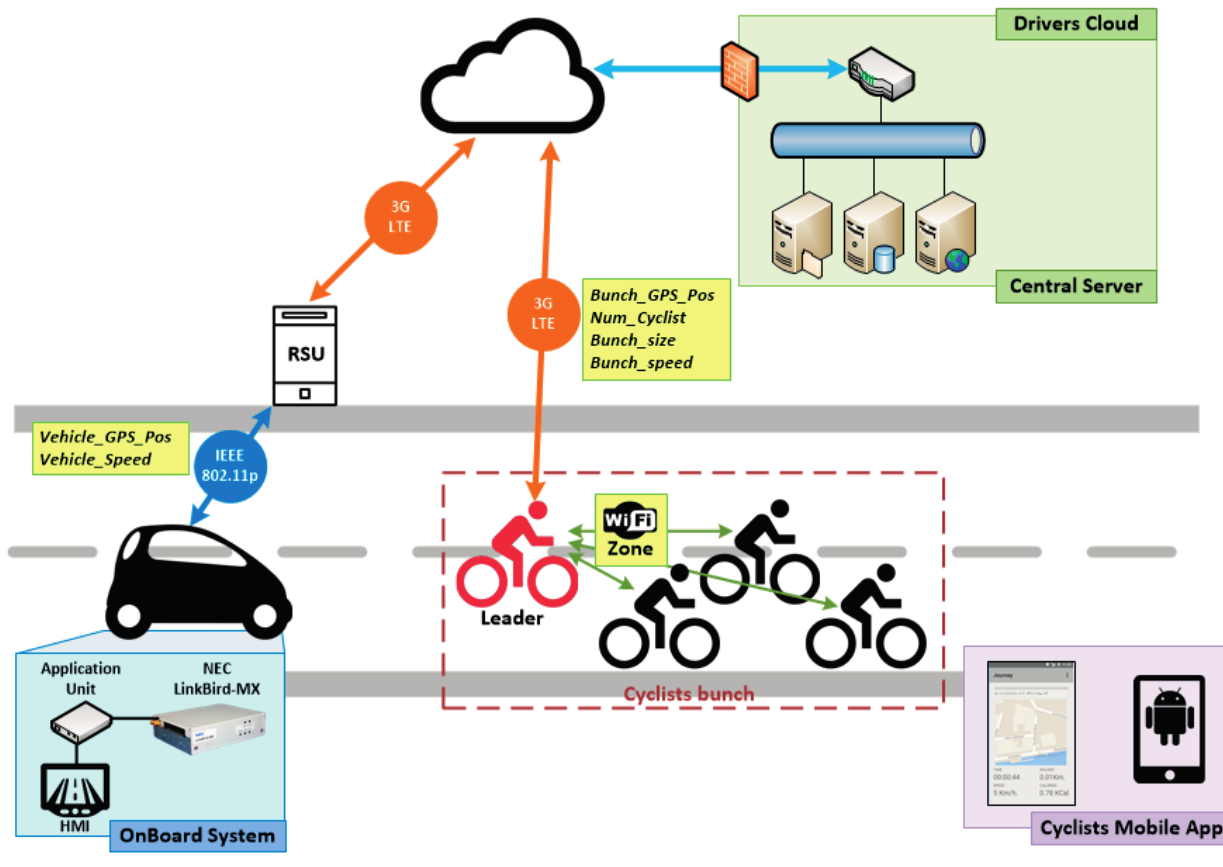
Figure 5. Description of the system